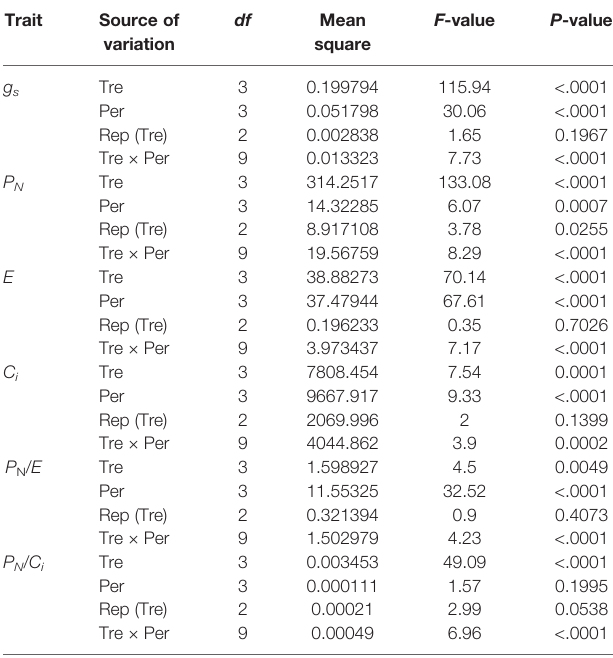
TABLE 1 | Analysis of variance (ANOVA) results for the effect of treatments (Tre), period (Per), and their interaction on stomatal conductance ( g s ), net photosynthetic rate ( P N ), transpiration rate ( E ), internal concentration of CO 2 ( C i ), instantaneous water use ef fi ciency ( P N / E ), and instantaneous carboxylation ef fi ciency ( P N / C i